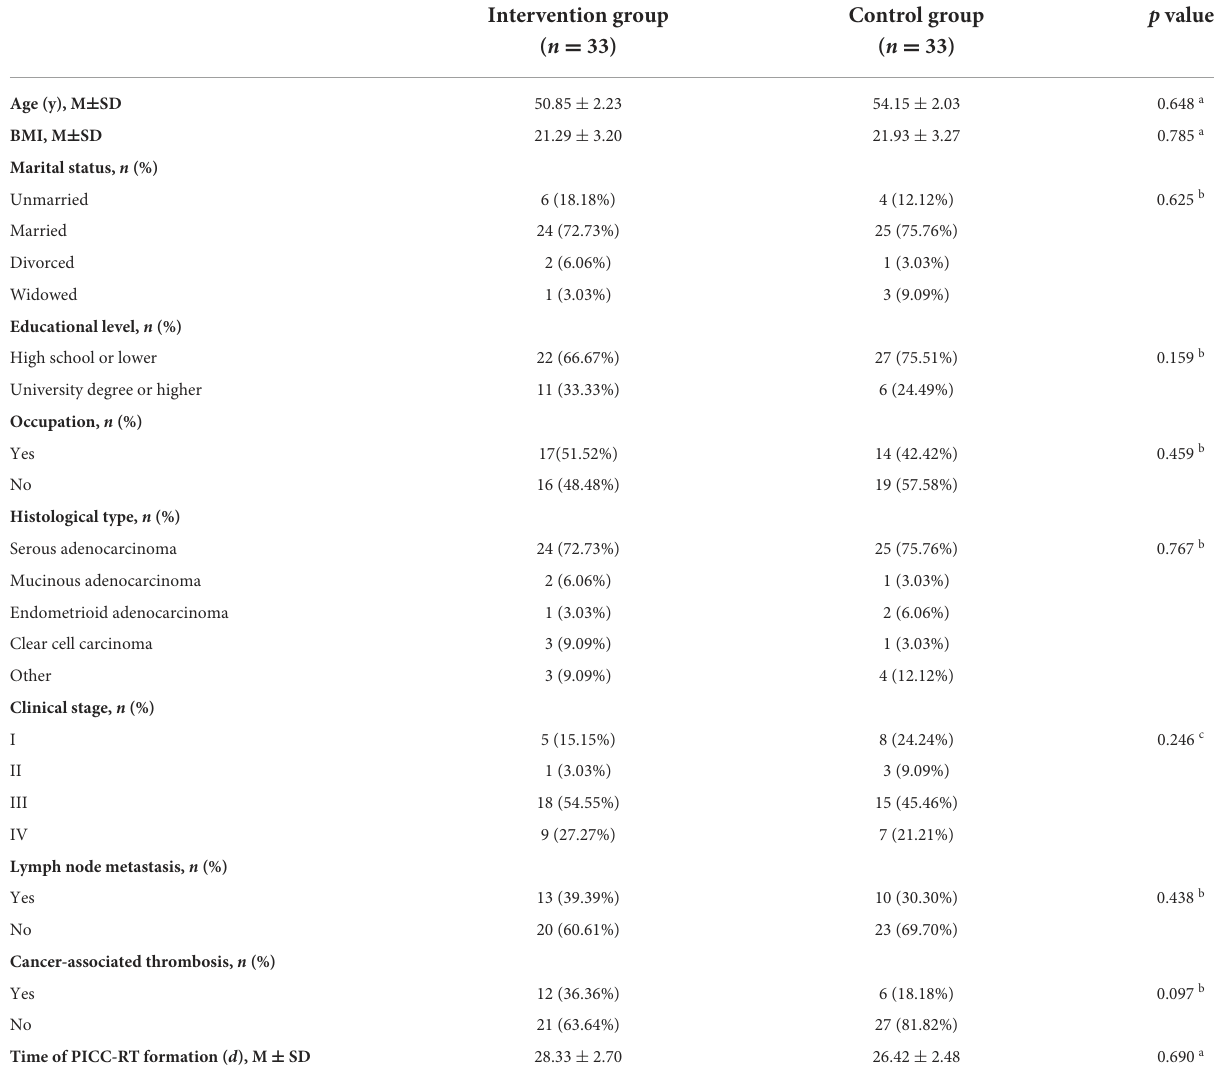
TABLE 2 General characteristics of the intervention and control